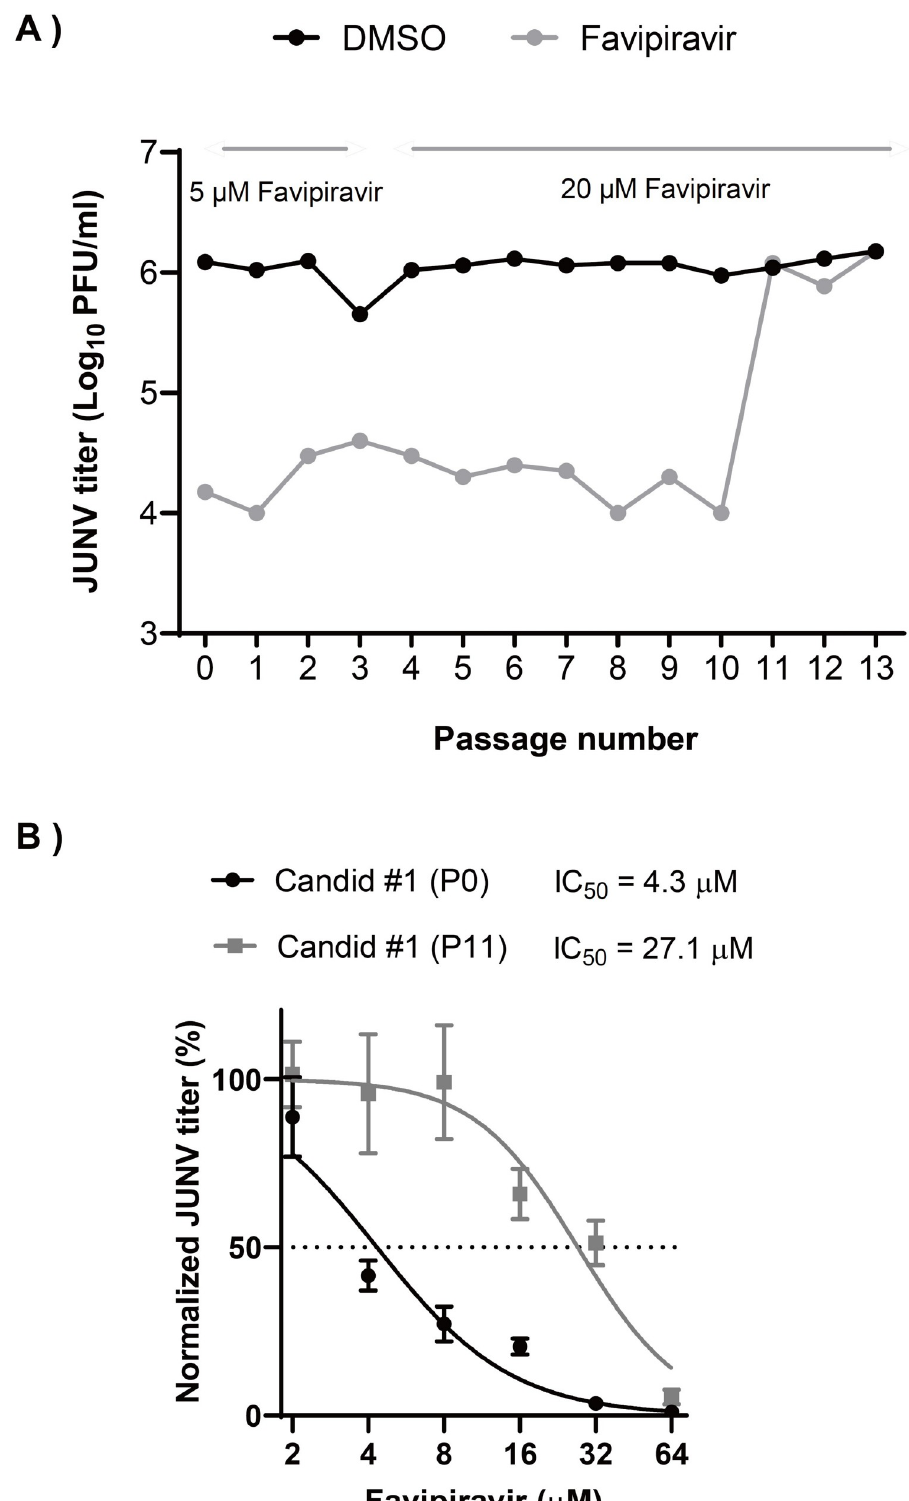
Fig 1. Emergence of favipiravir resistant JUNV by sequential passaging in 293T cells. (A) Serial passage of JUNV in presence of moderate favipiravir concentrations. JUNV was passaged in 293T cells (MOI: 0.01) in presence of 5 μ M